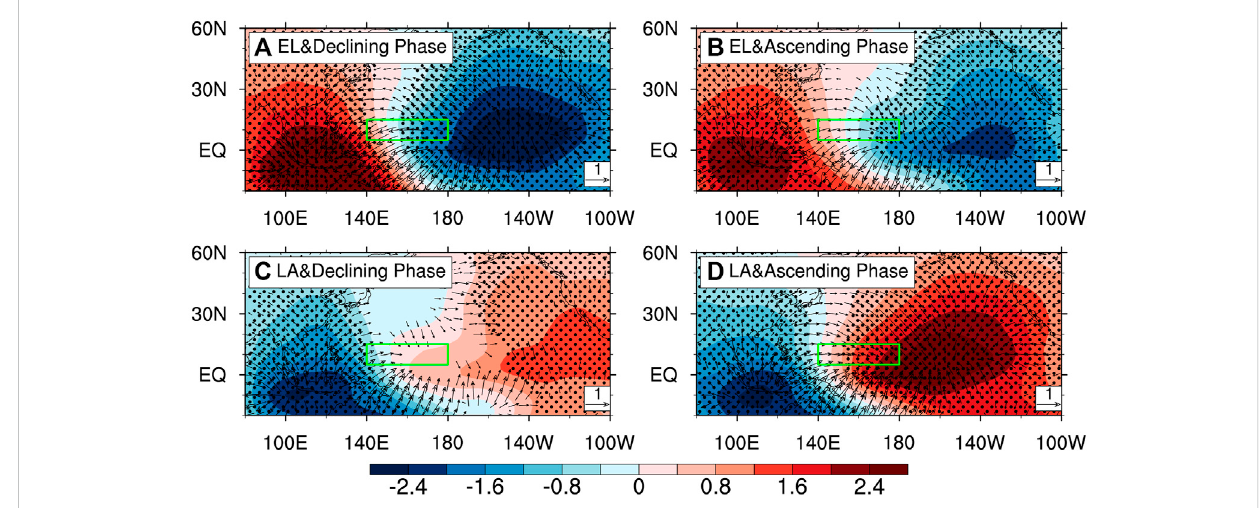
FIGURE 7 Composite velocity potential anomalies (shaded; units: 10 6 m 2 s − 1 ) and divergent wind anomalies at 200 hPa (vector; units: m s − 1 ) in JJASON in (A) , (B) ElNiñoand (C) , (D) LaNiñayearsduringdifferentsolarcyclephases.Dots(vectors)indicatevelocitypotential(divergentwind)anomaliesaresigni fi cant at the 99% con fi dence